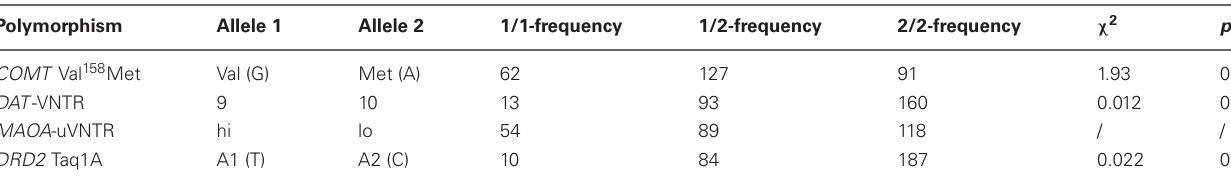
Table 5 | Genotype distributions and fit to the Hardy–Weinberg